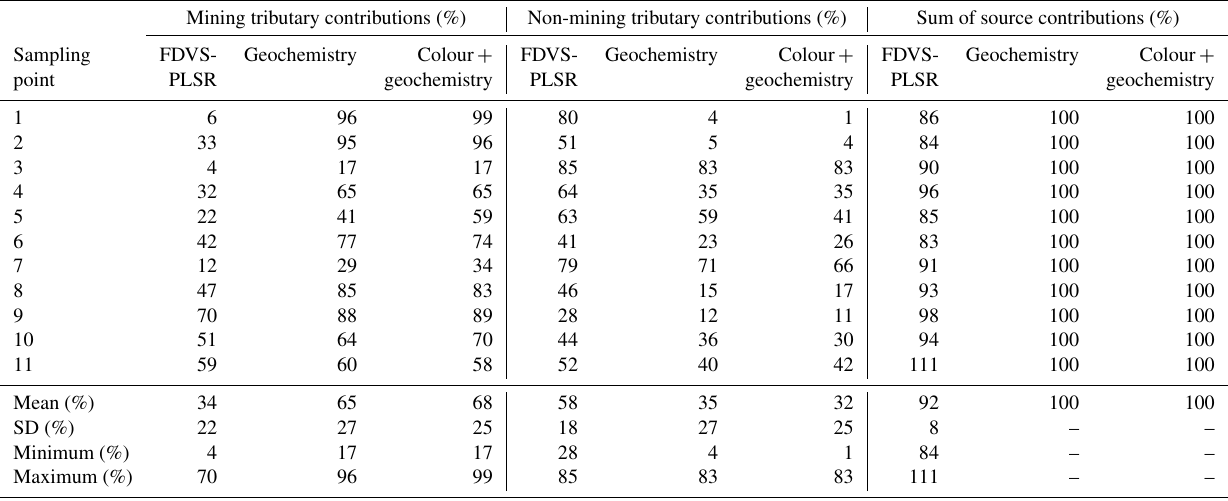
Table 4. Source contributions calculated by FDVS-PLSR, geochemistry and colour + geochemistry approaches for sediment deposited during the flood of 25 February 2015.